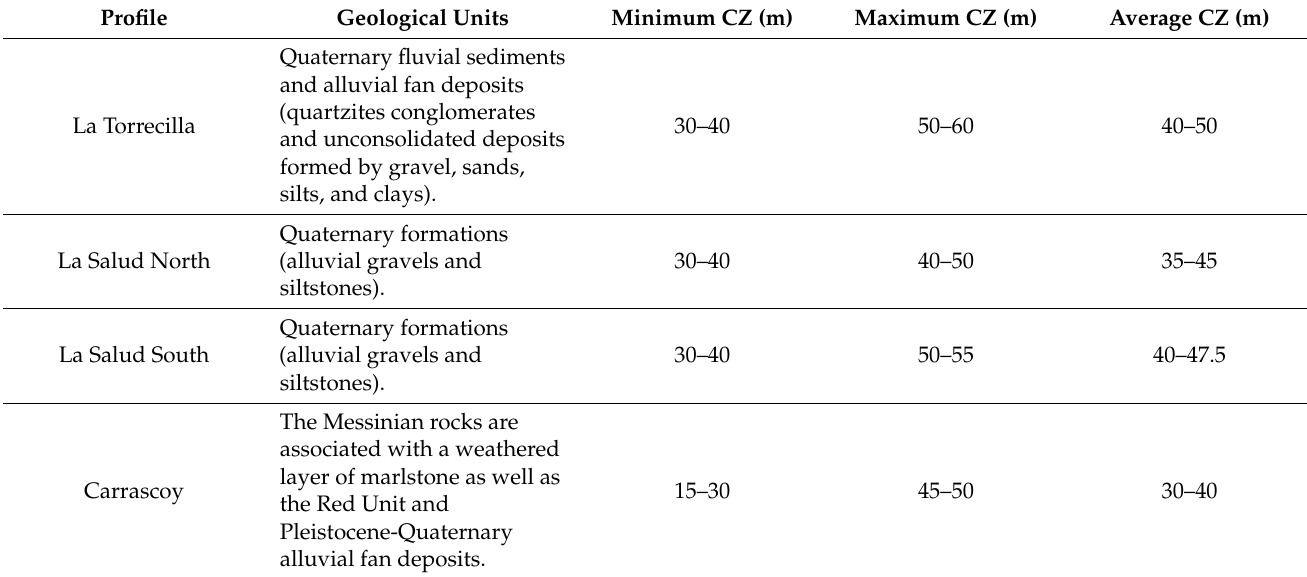
Table 3. Relationship between CZ thickness and the different geological units that host